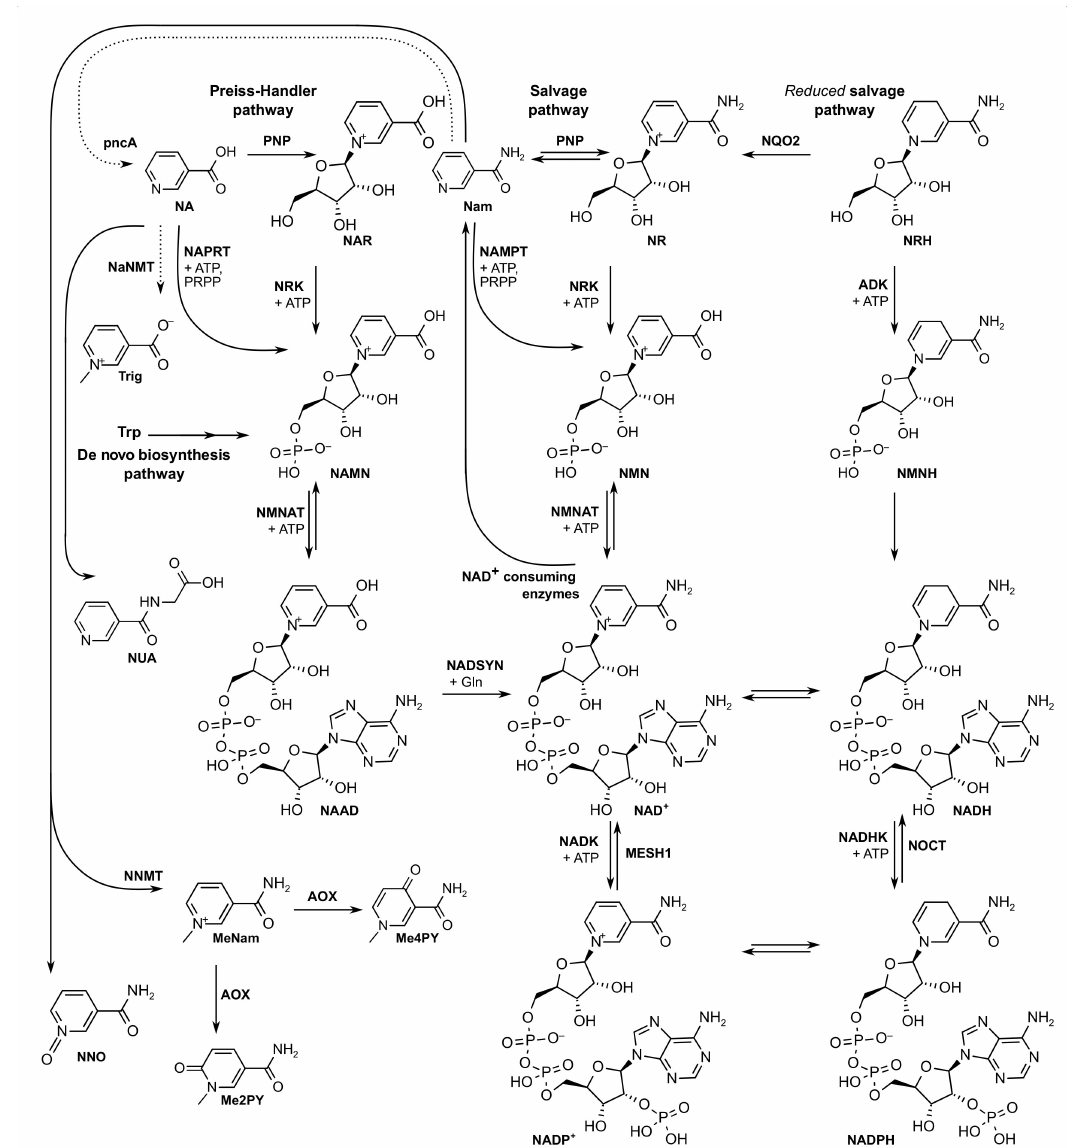
Figure 1. The NAD + metabolome of biosynthetic pathways of NAD(P)(H), including all metabolites monitored in this study. Metabolites with chemical structures are monitored while those labeled only with acronyms were not monitored in this method. NAD + consuming enzymes include specifically: sirtuins, ADP-ribosyl cyclases, SARM or PARPs. All enzymatic steps were found in mammalians unless indicated by dashed arrows, according to KEGG [29]. Metabolites with structure: NA: nicotinic acid; NAR: nicotinic acid riboside; Nam: nicotinamide; NR: nicotinamide riboside; NRH: nicotinamide riboside, reduced form; NAMN: nicotinic acid mononucleotide; NMN: nicotinamide mononucleotide; NMNH: nicotinamide mononucleotide, reduced form; NAAD: nicotinic acid adenine dinucleotide; NAD + : nicotinamide adenine dinucleotide; NADH: nicotinamide adenine dinucleotide, reduced form; NADP + : nicotinamide adenine dinucleotide monophosphate; NADPH: nicotinamide adenine dinucleotide monophosphate, reduced form; Trig: trigonelline; MeNam: N -methylnicotinamide; Me2PY: N -methyl-2-pyridone-5-carboxamide; Me4PY: N -methyl-4-pyridone-3-carboxamide; NUA: nicotinuric acid; NNO: nicotinamide- N -oxide. Metabolites without defined chemical structures (not monitored): Trp: tryptophan; Gln: glutamine; ATP: adenosine triphosphate; PRPP: 5-Phosphoribosyl 1-pyrophosphate. Enzymes: pncA: Nicotinamidase; PNP: purine nucleosidase; NQO2: N -ribosyldihydronicotinamide quinone reductase 2; ADK: adenosine kinase; NAPRT: NA phosphoribosyltransferase; NAMPT: Nam phosphoribosyltransferase; NRK: NR kinase; NMNAT: NMN adenyltransferase; NADSYN: NAD + synthetase; NADK: NAD + kinase; NADHK: NADH kinase; AOX: Aldehyde oxidase; NNMT: Nicotinate N -methyltransferase; NaNMT: NA phosphoribosyltransferase; MESH1: NADPH phosphatase; NOCT: